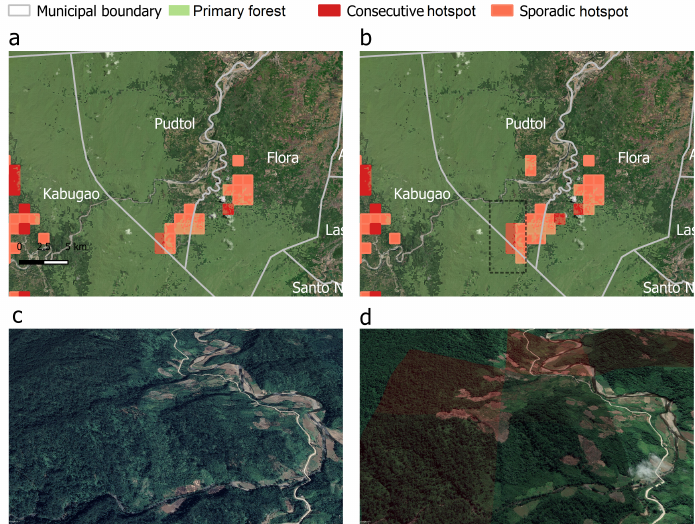
Figure 7. A sample hotspot development using the GLAD alerts in 2020 driven by slash-and-burn and overlapping several municipalities in Apayao province. The 1st and 2nd quarter hotspot maps are shown in ( a , b ) while ( c , d ) show the actual landscape in mid-2019 and mid-2020, respectively (images from Google Earth Pro).